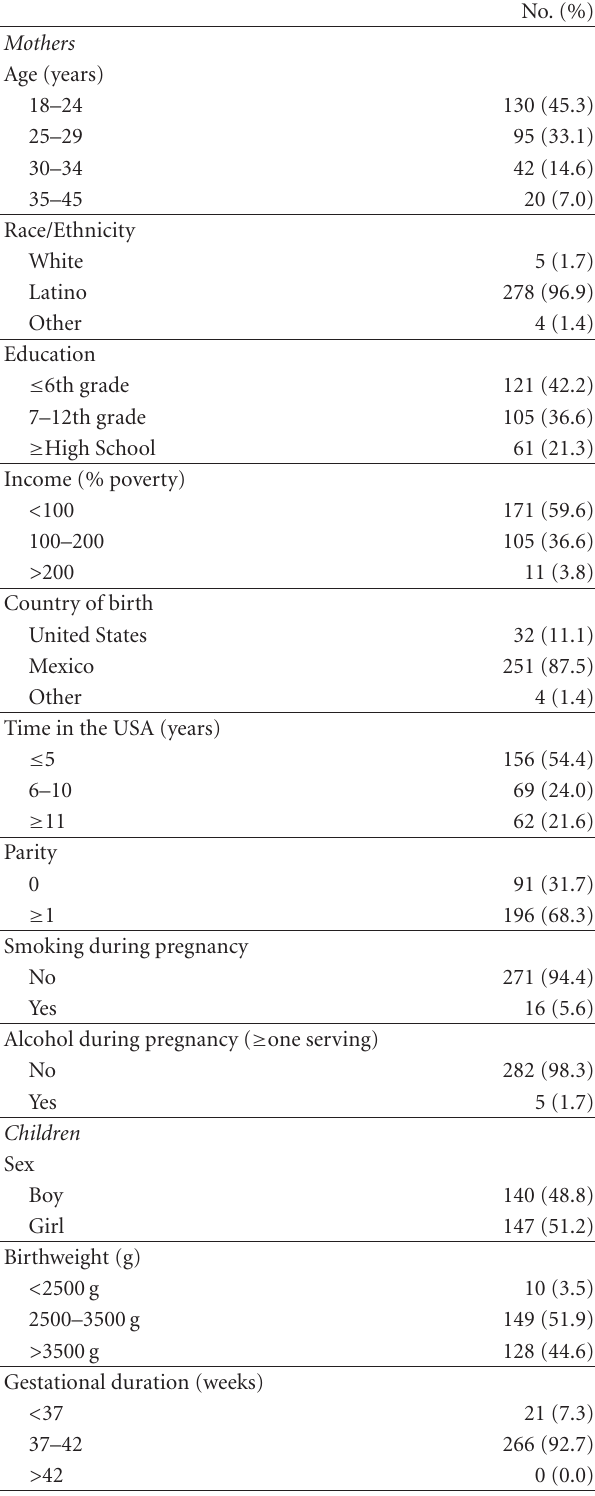
Table 1: Demographic characteristics of study participants ( n =